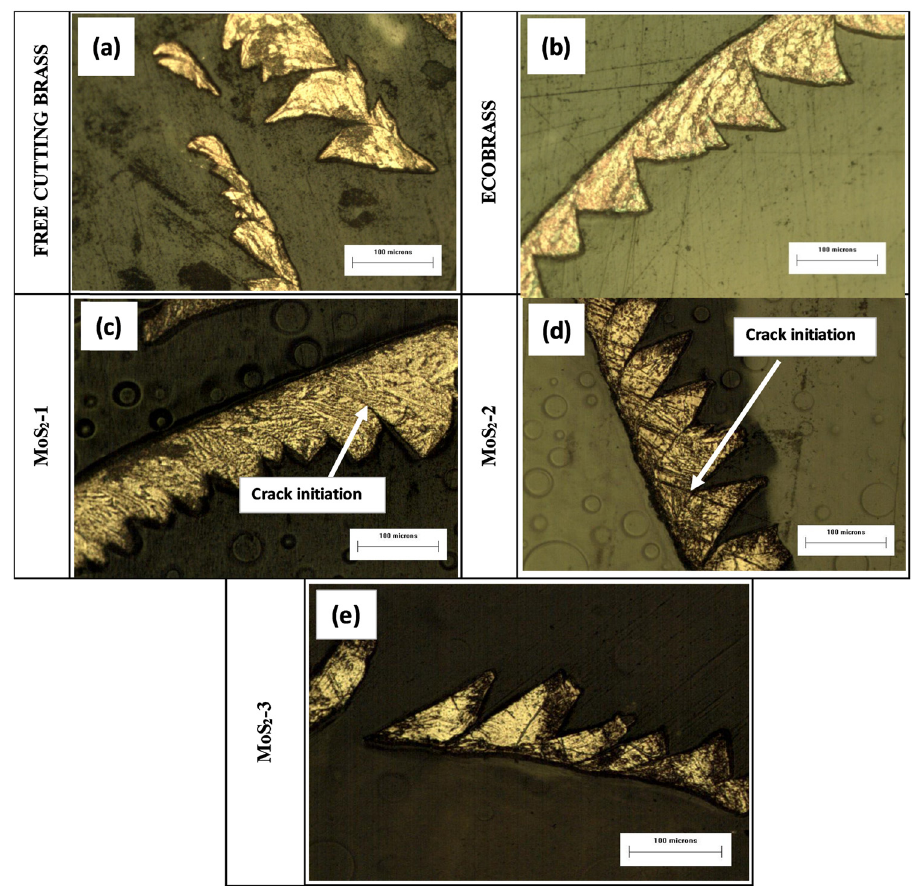
Figure 8: Optical microscopy images of chip formation for ( a ) F.C.B; ( b ) Ecobrass; ( c ) MoS 2 - 1; ( d ) MoS 2 - 2; and ( e ) MoS 2